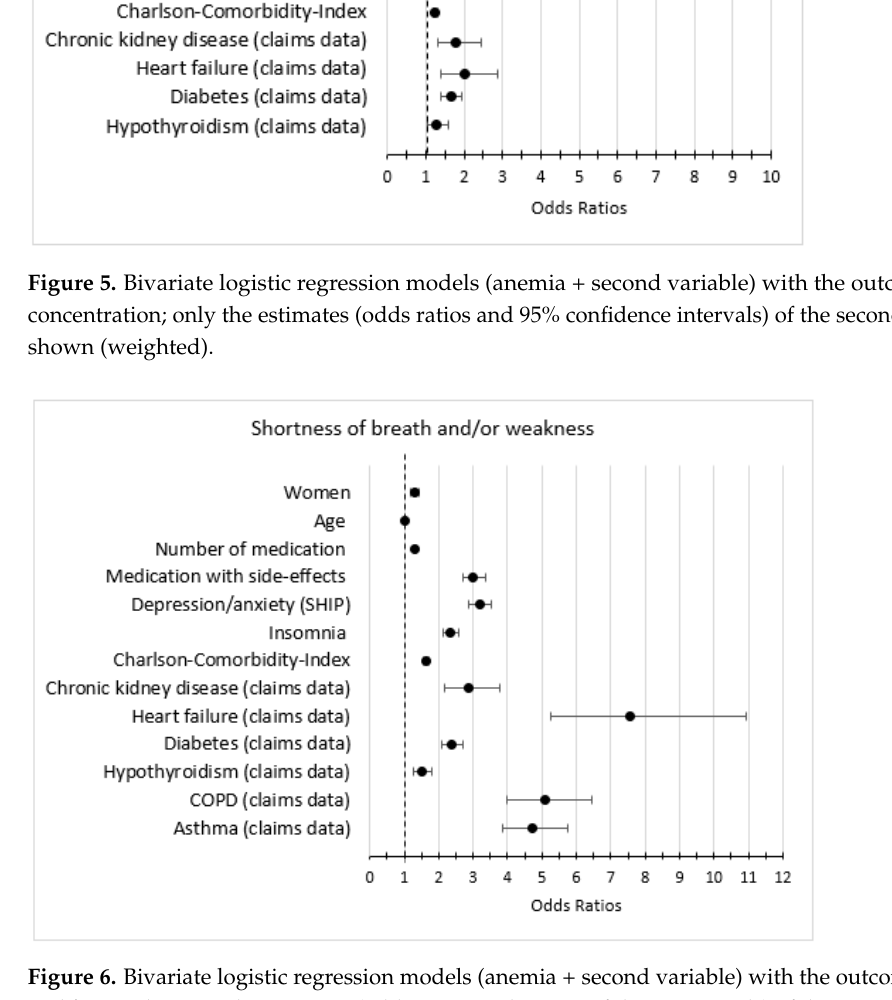
Figure 6. Bivariate logistic regression models (anemia + second variable) with the outcome dyspnea and/or weakness; only estimates (odds ratios and 95% confidence intervals) of the second variable is shown (weighted) .